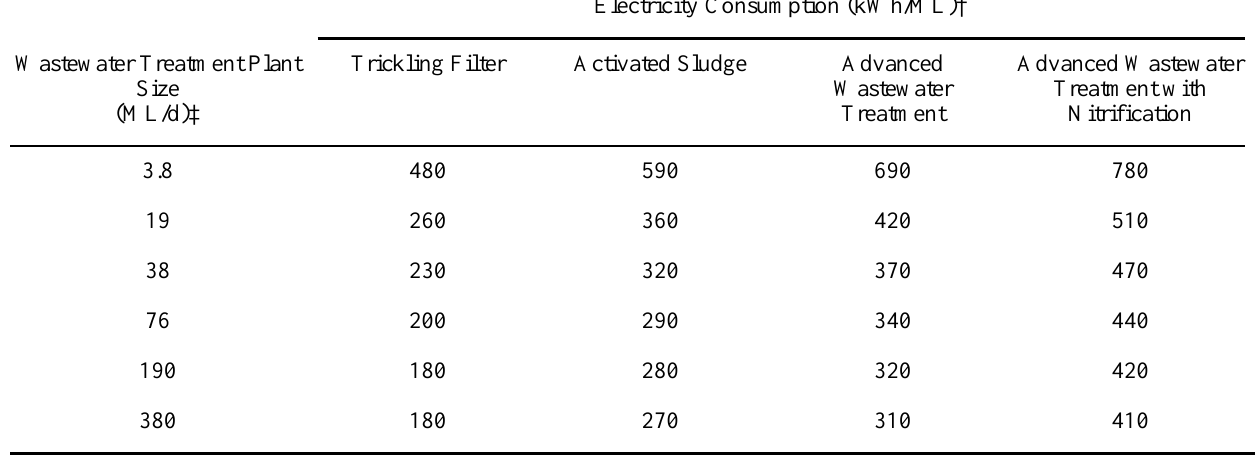
Table 4 . Variation in unit electricity consumption for different sizes of wastewater treatment plants (Goldstein and Smith 2002b). Larger wastewater treatment plants exhibit economies of scale with lower energy requirements per volume of wastewater